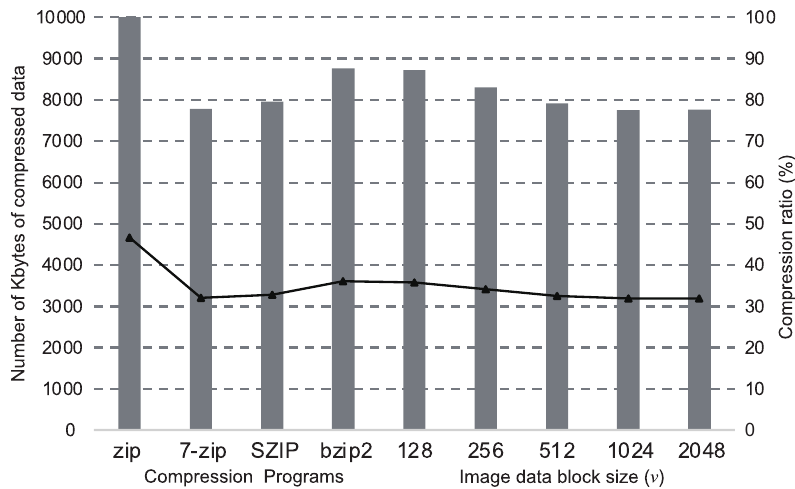
Figure 5. Comparisons of compression ratios with/without the DNN inference in the case of Beauty.